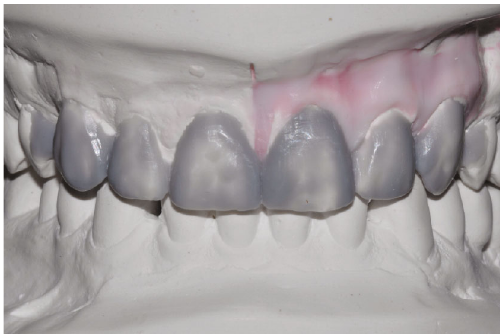
Figure 2: Initial diagnostic